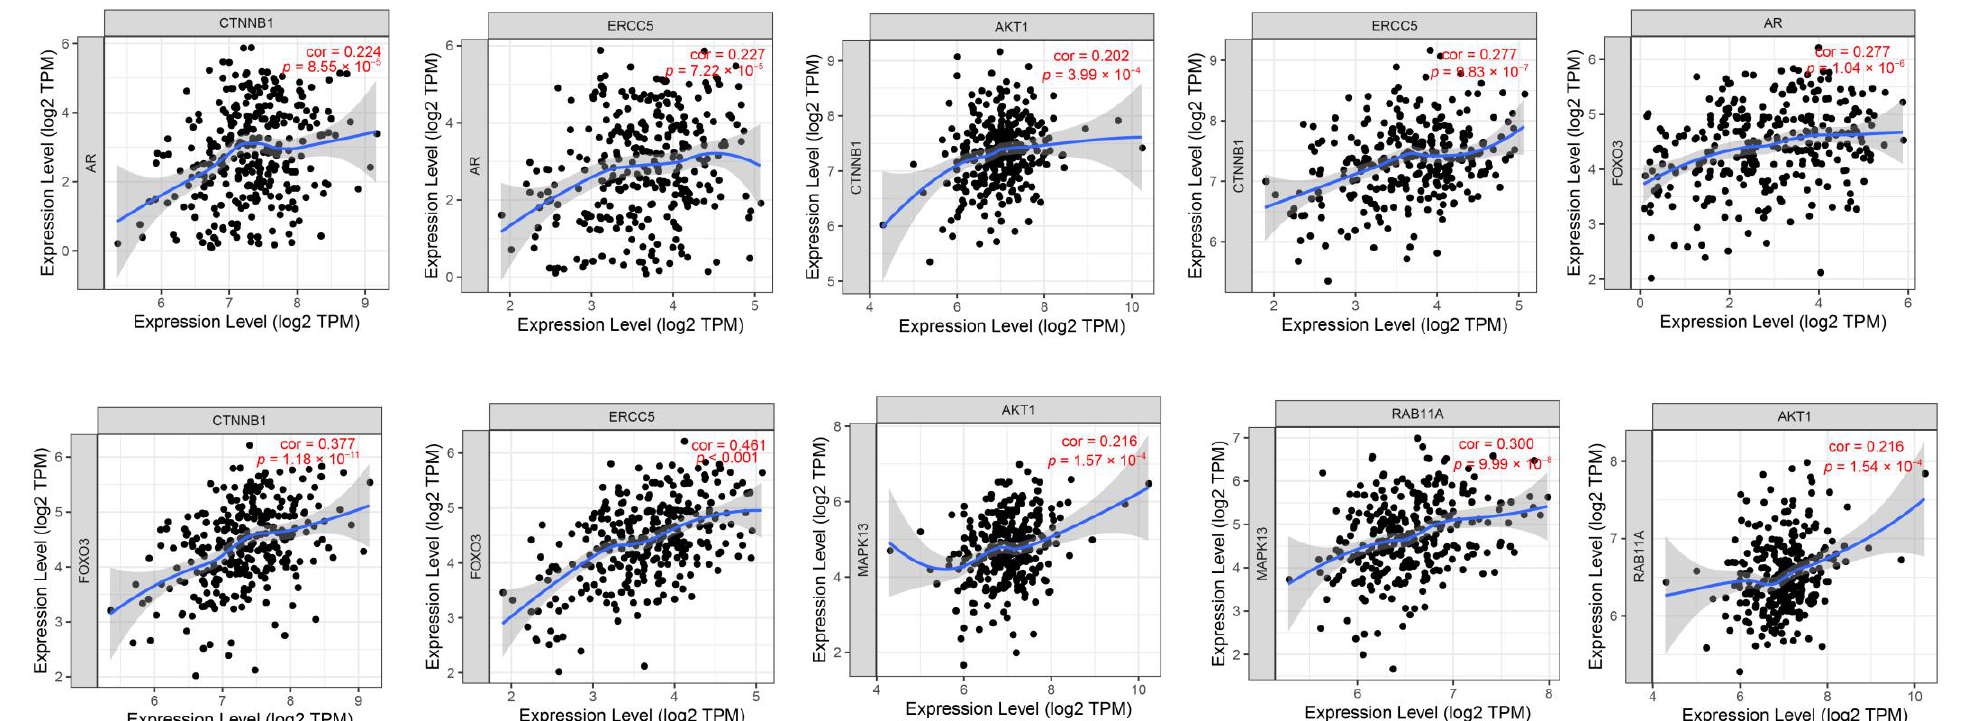
Figure 12. The correlation of the protein-coding genes in the TIMER database.